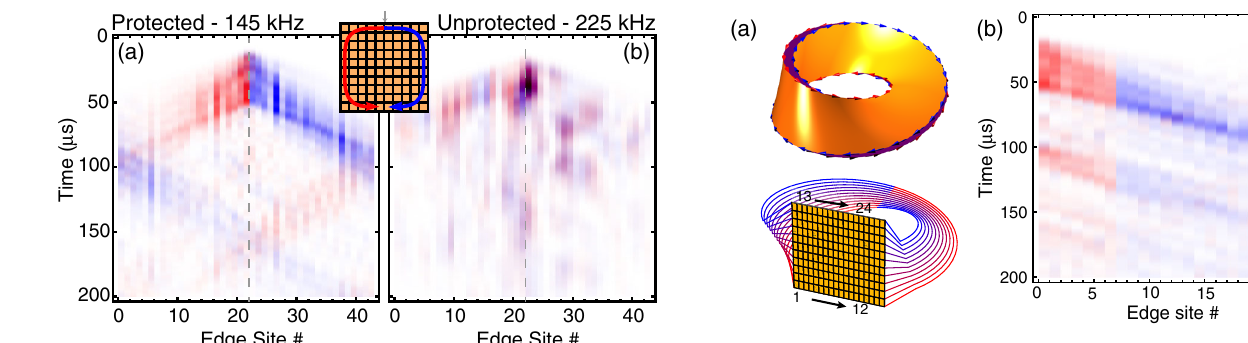
FIG. 3. Time-resolved transport dynamics of the edge modes. (a) Spin-resolved detection of the splitting of a localized A -site ¼ ffiffiffi p ð ↑ þ ↓ Þ = 2 excitation in the protected gap (at 145 kHz). The ↑ (red) and ↓ (blue) signals are overlaid, demonstrating spin- momentum locking. Two round trips are visible; sites 0 and 42 are equivalent. (b) Spin-resolved excitation after exciting the same site in the unprotected upper edge mode at 225 kHz, where disorder immediately leads to backscattering for both spin states. Inset: Edge lattice-site numbering convention.